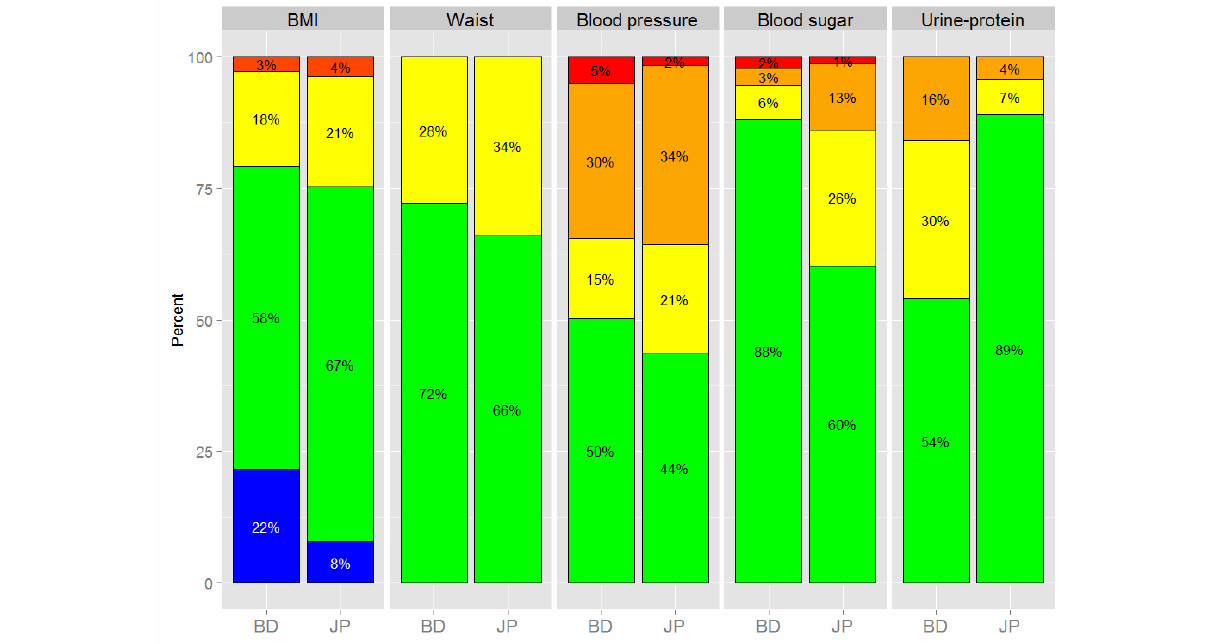
Figure 7. Comparison of health checkup results for Bangladeshi (BD) and Japanese (JP)